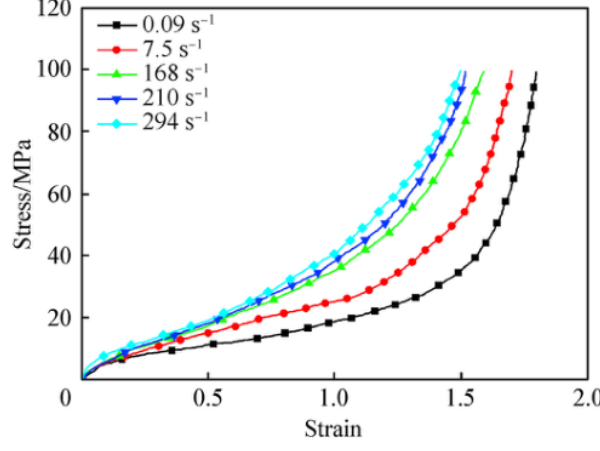
Figure 3. Stress − strain curve for polyurea at various strain rates. [26].